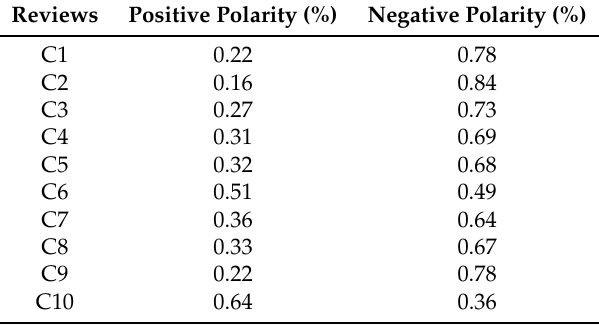
Table 1. Polarity of reviews related to the security of the Instagram application.